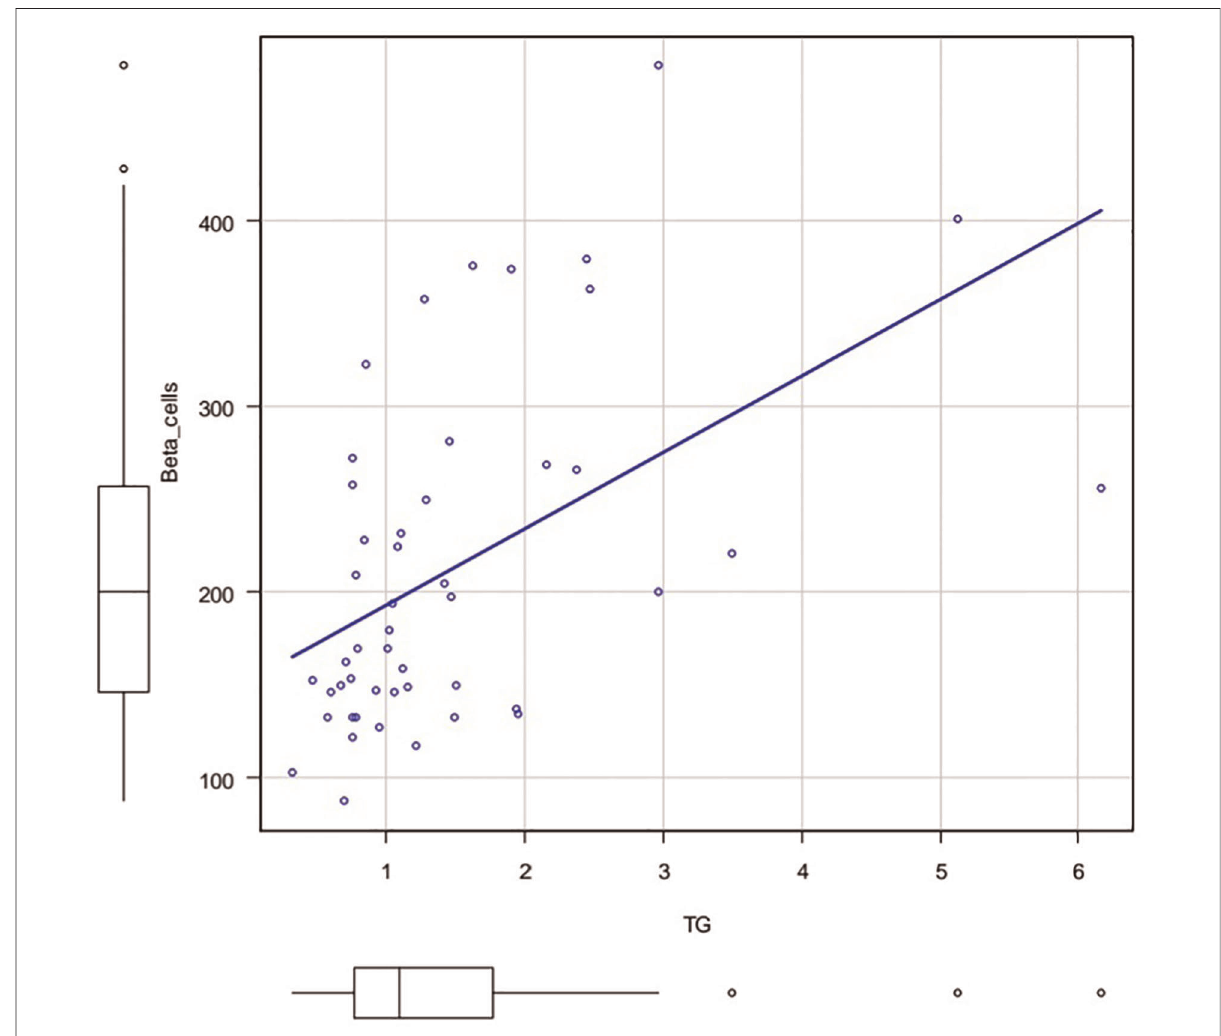
FIGURE 3 Correlation fi eld in coordinates: TG (X axis) and %B (Y axis). Spearman ’ s rank correlation coef fi cient 0.53 p